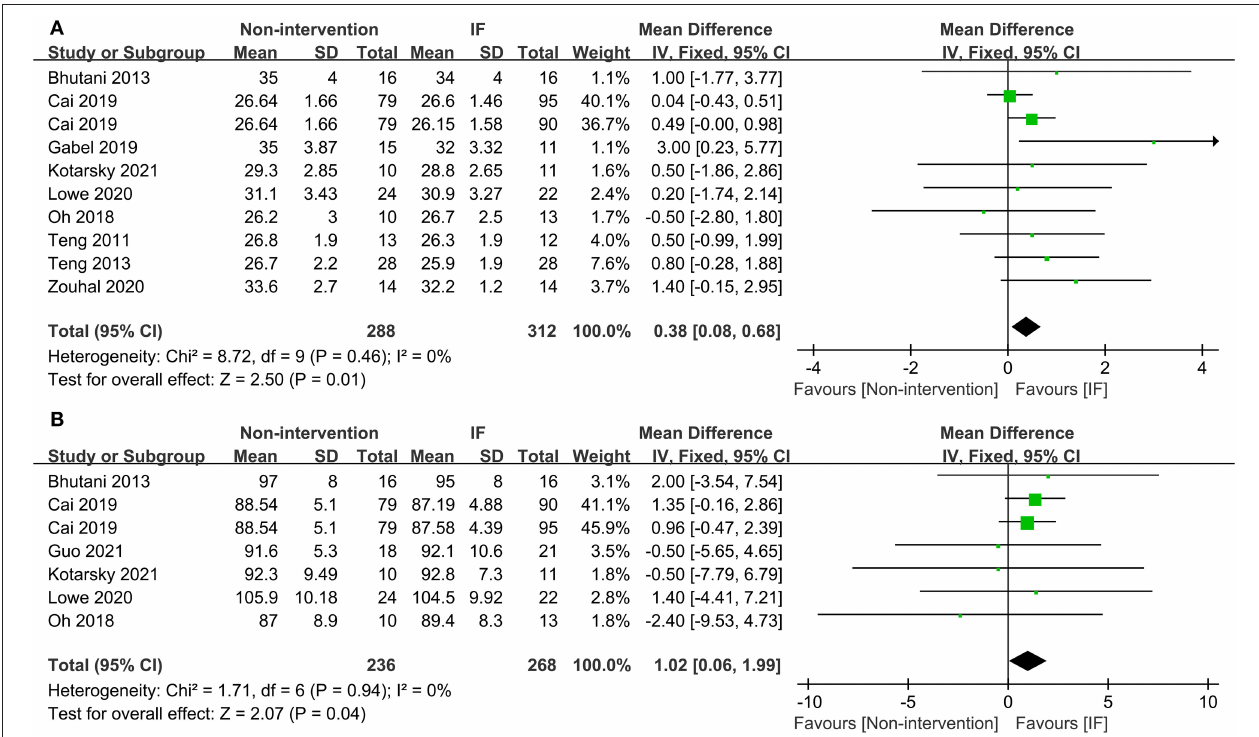
FIGURE 2 | Forest plots for the body mass index (BMI) and waist circumference (WC) of intermittent fasting (IF) vs. non-intervention diet. (A) BMI; (B) WC.